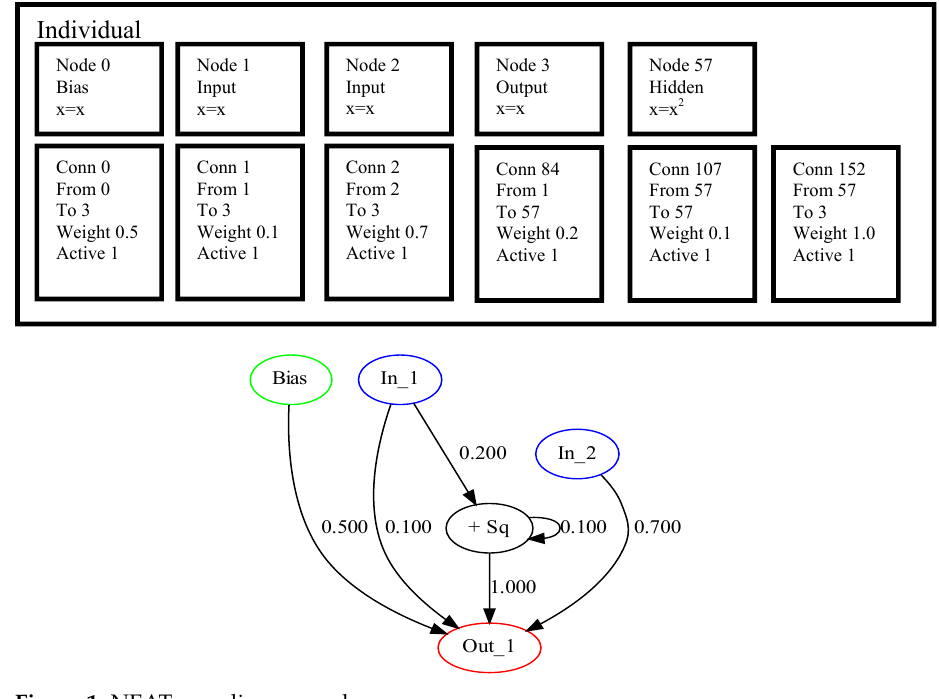
Figure 1. NEAT encoding